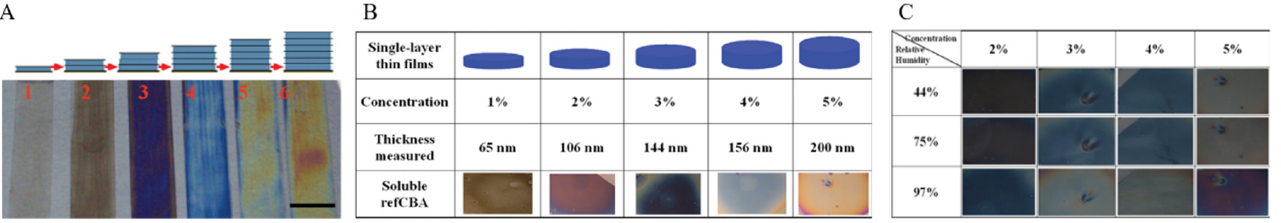
Figure 5. ( A ) RefCBA films of different layers (as red numbers in the figure) prepared by the spin- coating method; ( B ) RefCBA films of different thicknesses; ( C ) Dynamic color response of RefCBA films of different thicknesses under different relative humidity [23]. Copyright 2013, Wiley Period- icals, Inc.